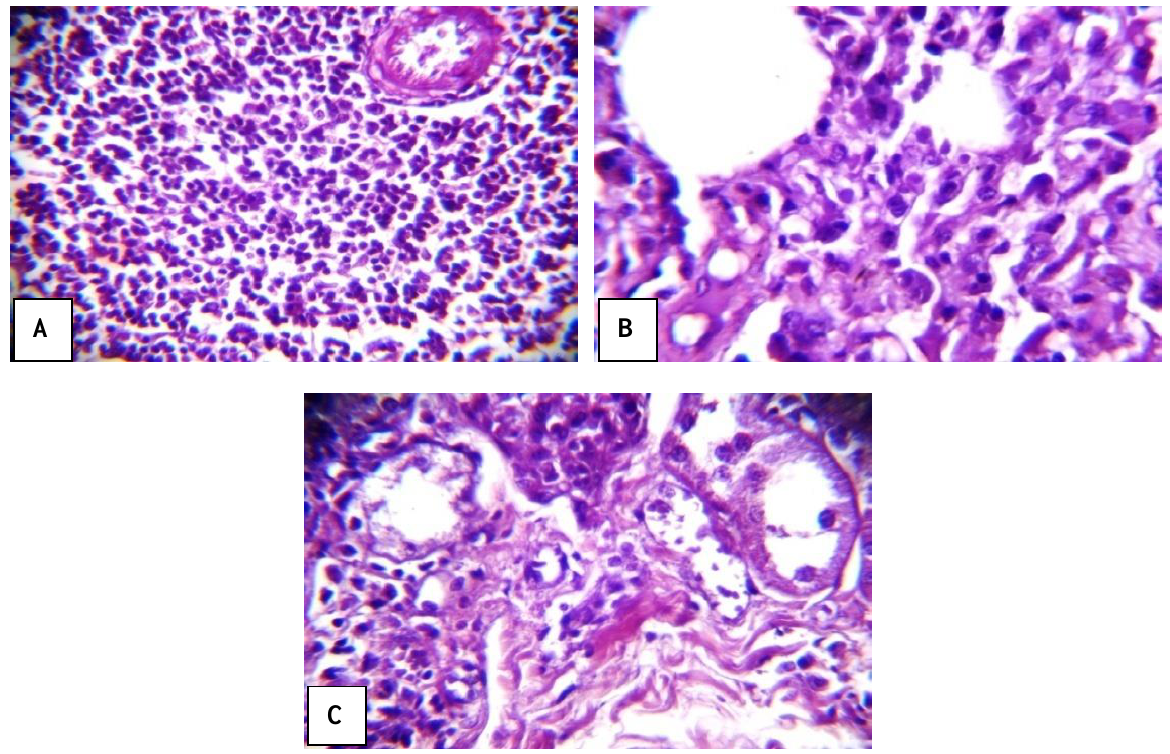
Fig, 5: Histological sections in the internal organs of the non-immunized group at 30 day post inoculation showed, A: spleen hyperplasia of white pulp. B: Lung inflammatory cells in the wall and lumen of the alveoli. C: Kidney aggregation of inflammatory cell MNCs around the blood vessels, (All sections were stained with H & E stain; A and C 200X; B